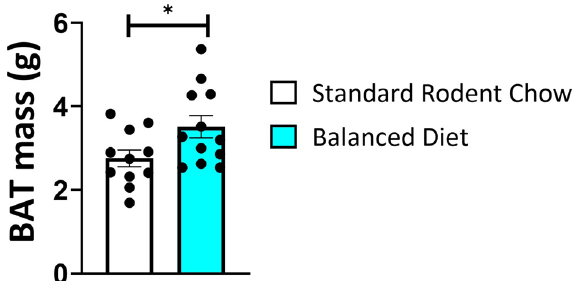
Figure 5. Brown Adipose Tissue (BAT) mass is increased in Balanced Diet AGS (*p = 0.038, n = 11 Standard Rodent Chow, n = 12 Balanced Diet, t-test). BAT mass was sampled during the hibernation season in December. Data shown are mean ± SEM. Black dots are individual data points.